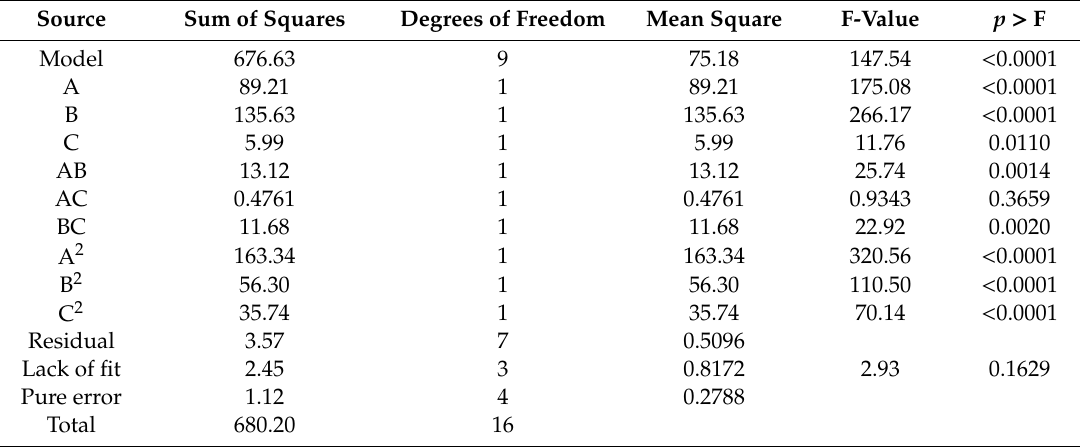
Table 1. ANOVA of the regression model obtained from response surface methodology